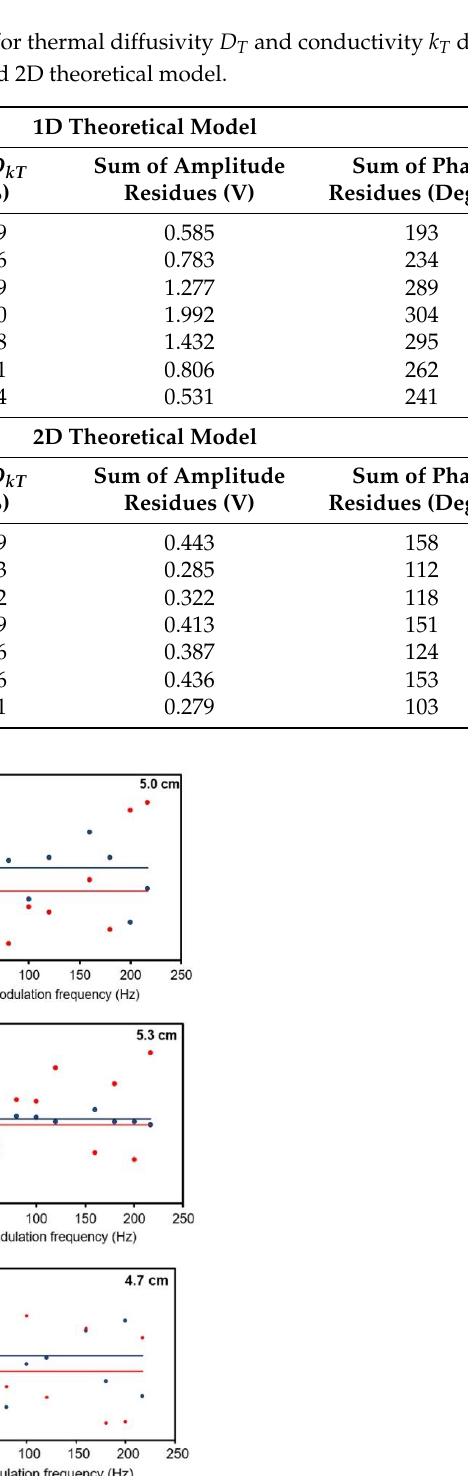
Figure 6. Distribution of residuals for ( i ) amplitude and ( ii ) phase using 1D and 2D models in the fitting procedure for the case of maximum PuB focussed f = 5.0 cm, and defocussed at f = 5.3 cm and at f = 4.7 cm. Table 4. Values of RSD and sum of residues for thermal diffusivity D T and conductivity k T determi- nation in case of the 1D theoretical model and 2D theoretical model.